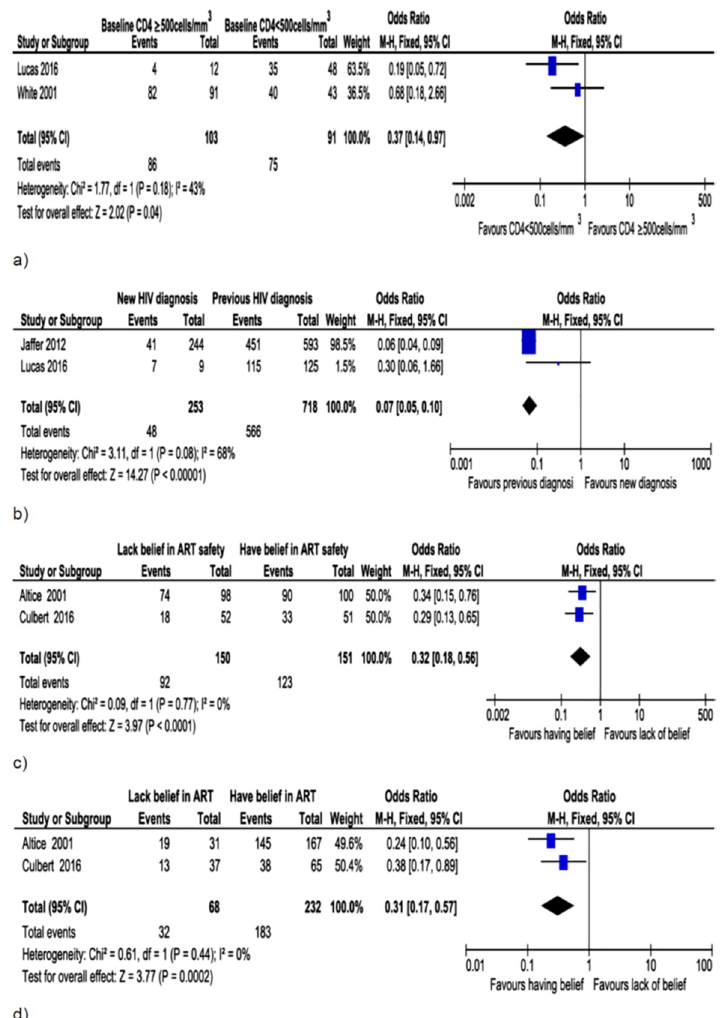
Fig 2. Forest plot of associations between ART initiation and baseline CD4 count (a), time of HIV diagnosis (b), belief in ART safety (c) and efficacy (d). Prisoners with higher baseline CD4 count (CD4 � 500cells/mm 3 ) and new HIV diagnosis, and those who lacked belief in ART safety and efficacy were less likely to initiate